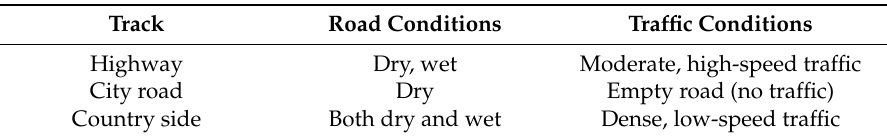
Table 2. Details of experimental tracks.